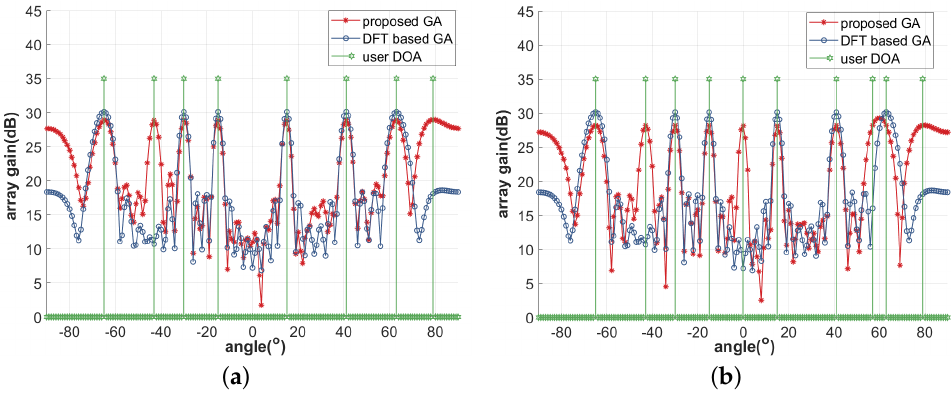
Figure 2. Array gain of massive array based on the proposed GAMP and the DFT-based GAMP: ( a ) on the condition that K = 8, ( b ) on the condition that K =